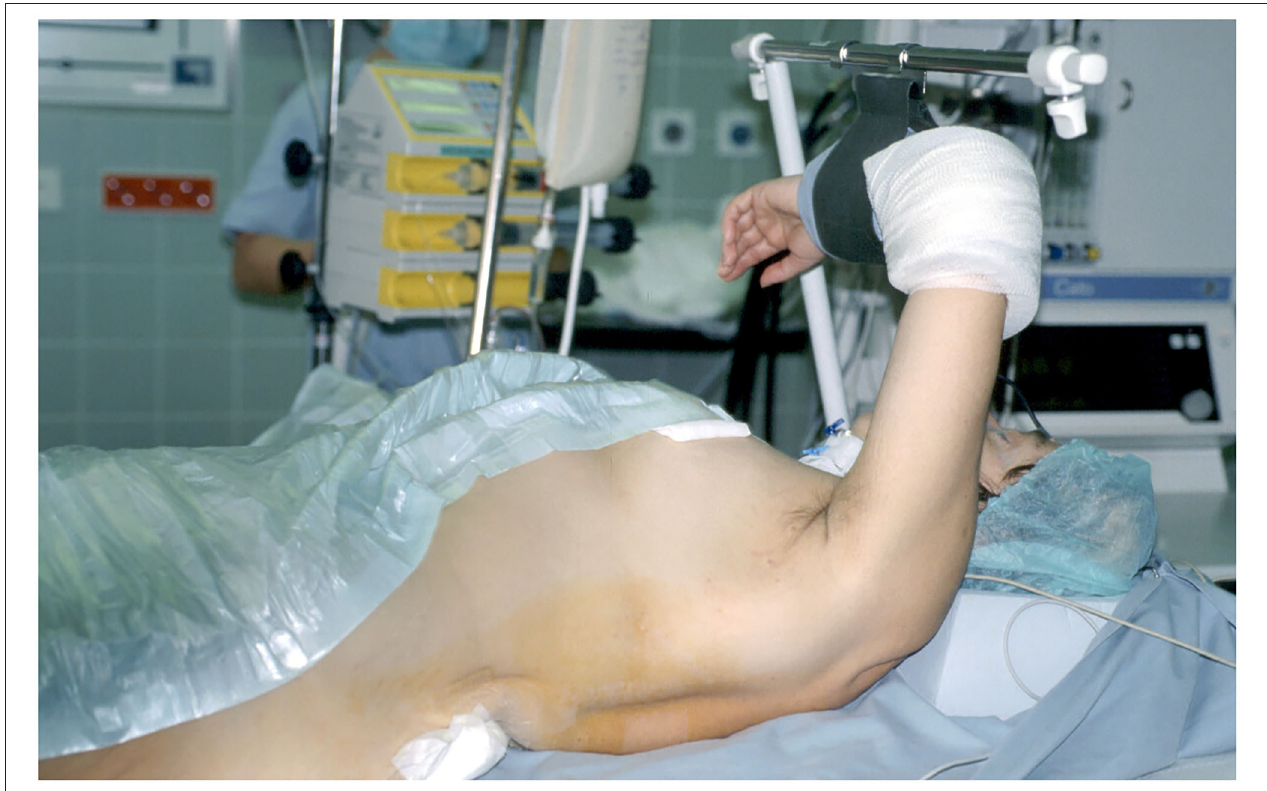
FIGURE 1 | Special positioning of the